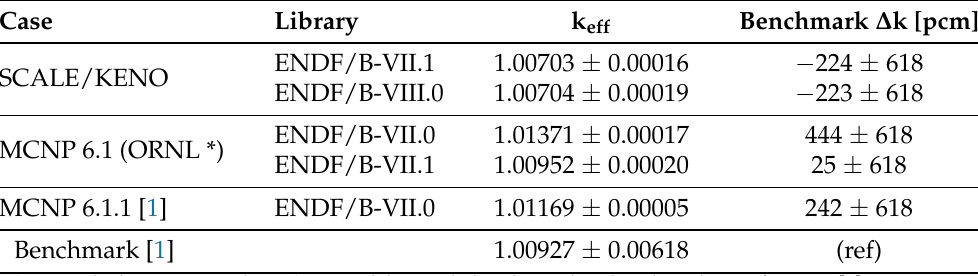
Table 2. KENO-CE EBR-II k eff results compared to the benchmark value and the MCNP-CE results.